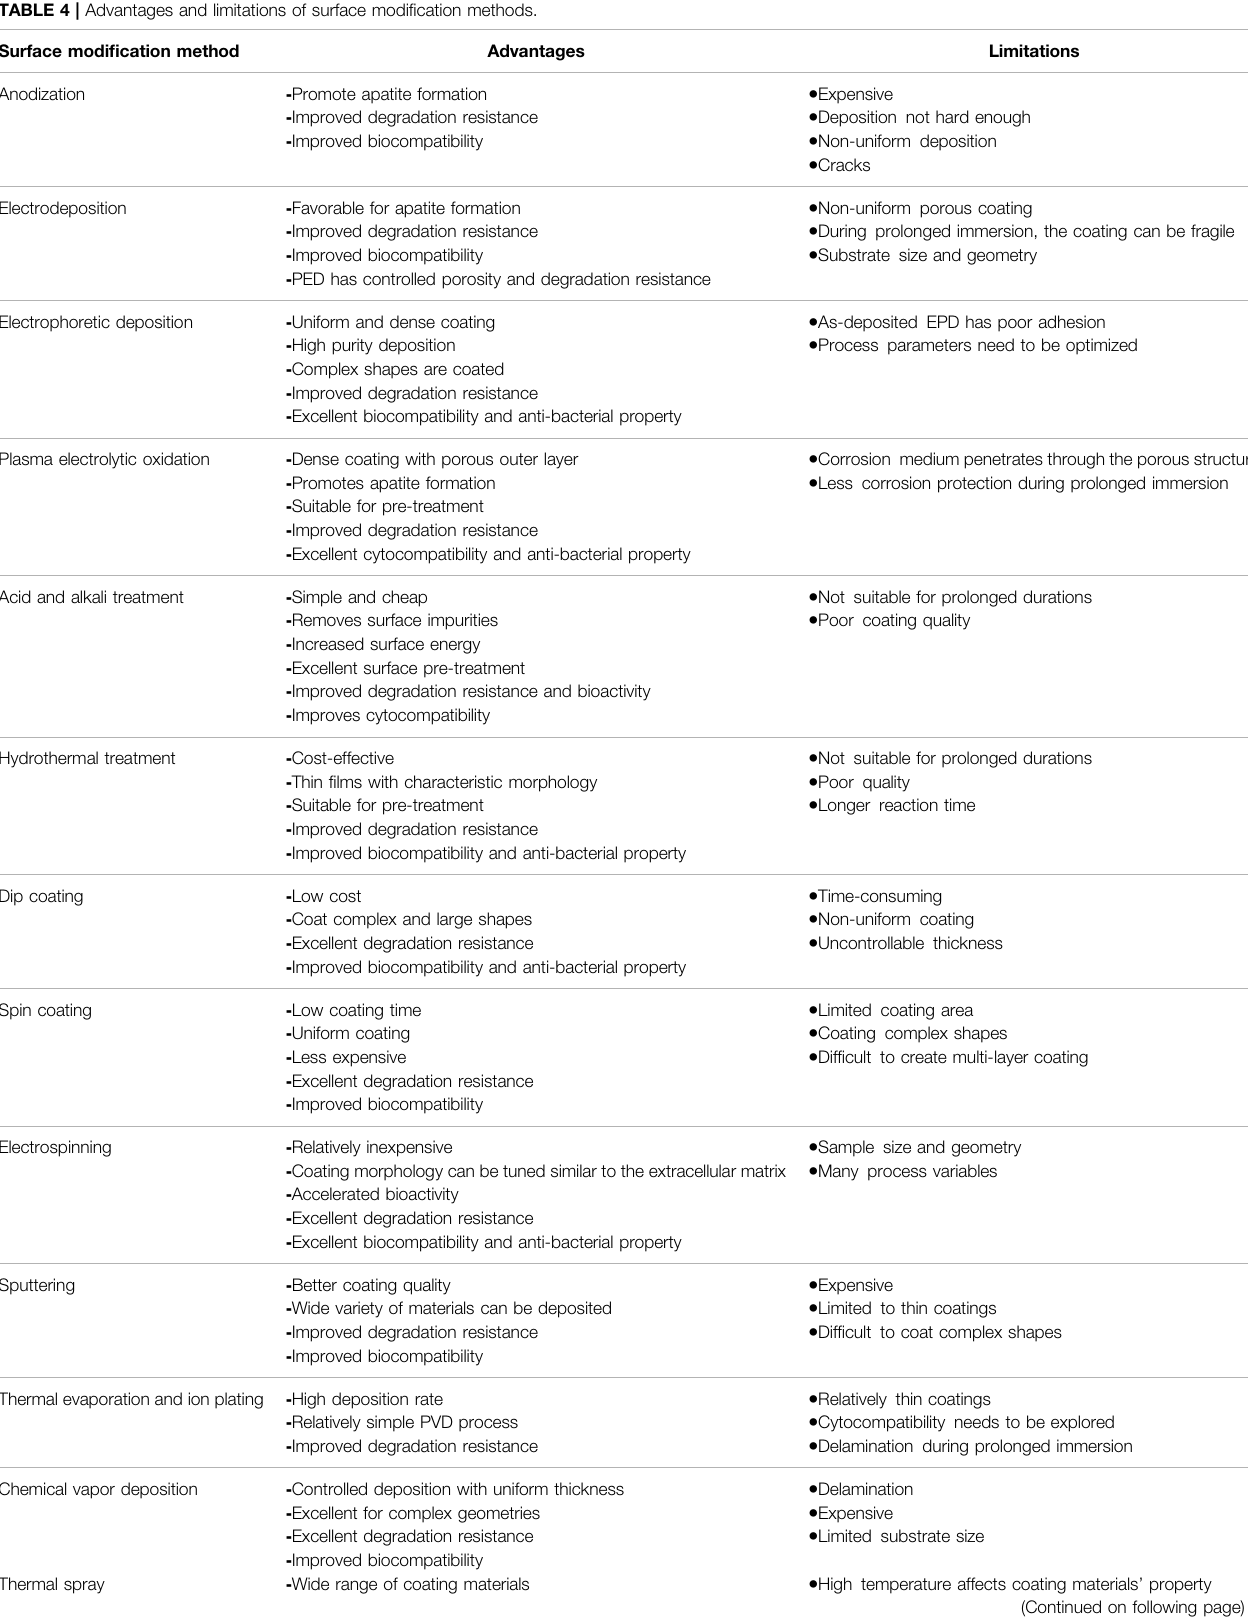
TABLE 4 | Advantages and limitations of surface modi fi cation